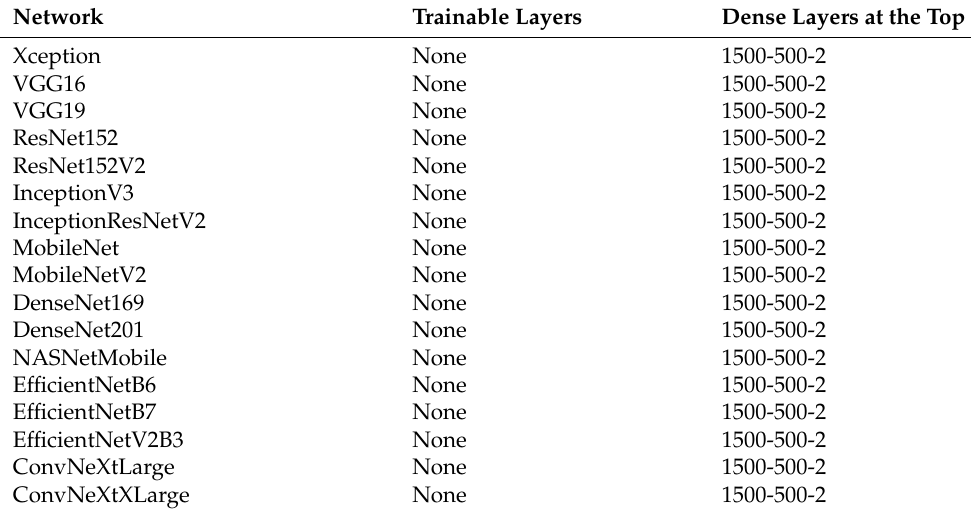
Table 3. Deep Learning networks of the